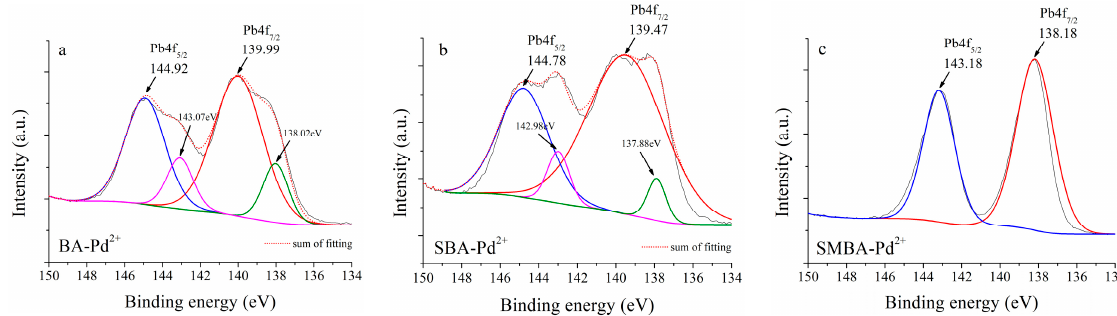
Figure 6. XPS spectra of ( a ) Pb4f for BA, ( b ) Pb4f for SBA, ( c ) Pb4f for SMBA.